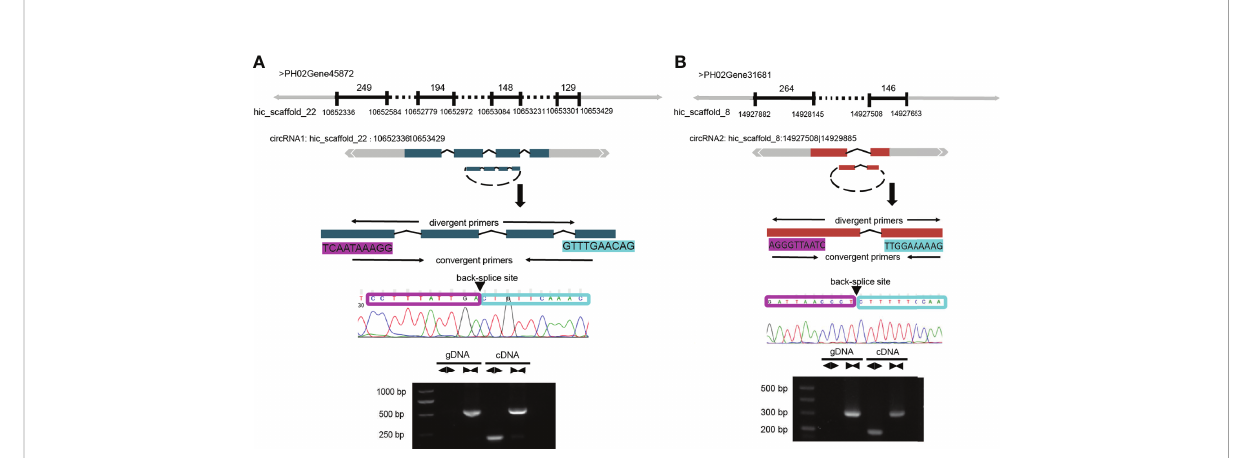
FIGURE 4 Validation of circRNAs by PCR and Sanger sequencing. (A) Schematic representation of the validation of circRNA1: hic_scaffold_22:10652336| 10653429. circRNA1 is formed after the circularization of 4 exons in the PH02Gene45872 gene. (B) Schematic representation of the validation of circRNA2: hic_scaffold_8:14927508|14929885. circRNA2 is formed after the circularization of 2 exons in the PH02Gene31681 gene. PCR ampli fi cation was performed after designing two sets of primers (convergent and divergent) for these two genes; clear bands could be observed in the products by agarose gel electrophoresis (AGE), and the ampli fi ed products could be sequenced to obtain the complete sequences at the fi rst and last junctions.